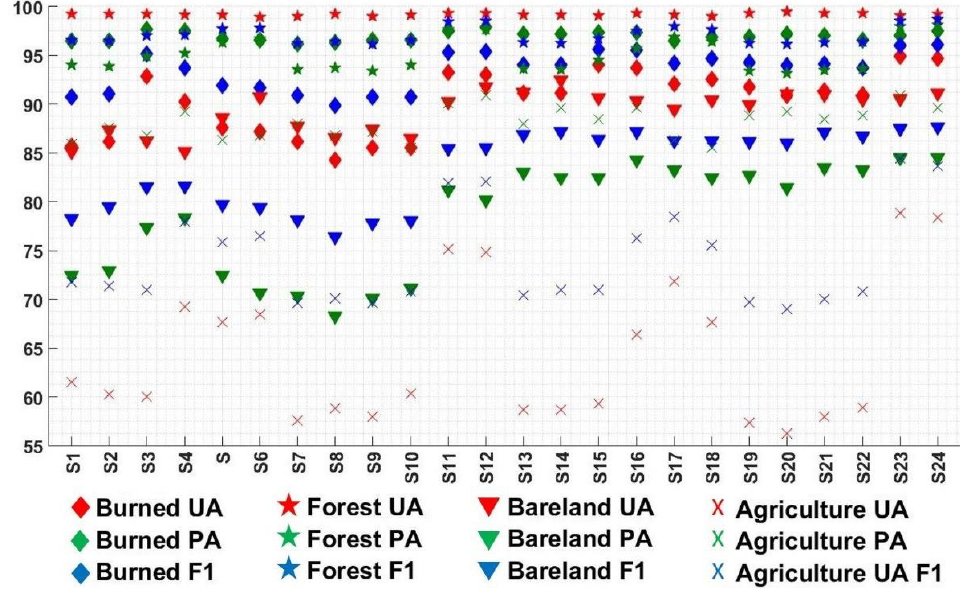
Figure 4. User accuracy (UA) and producer accuracy (PA) of each class (the details are presented in